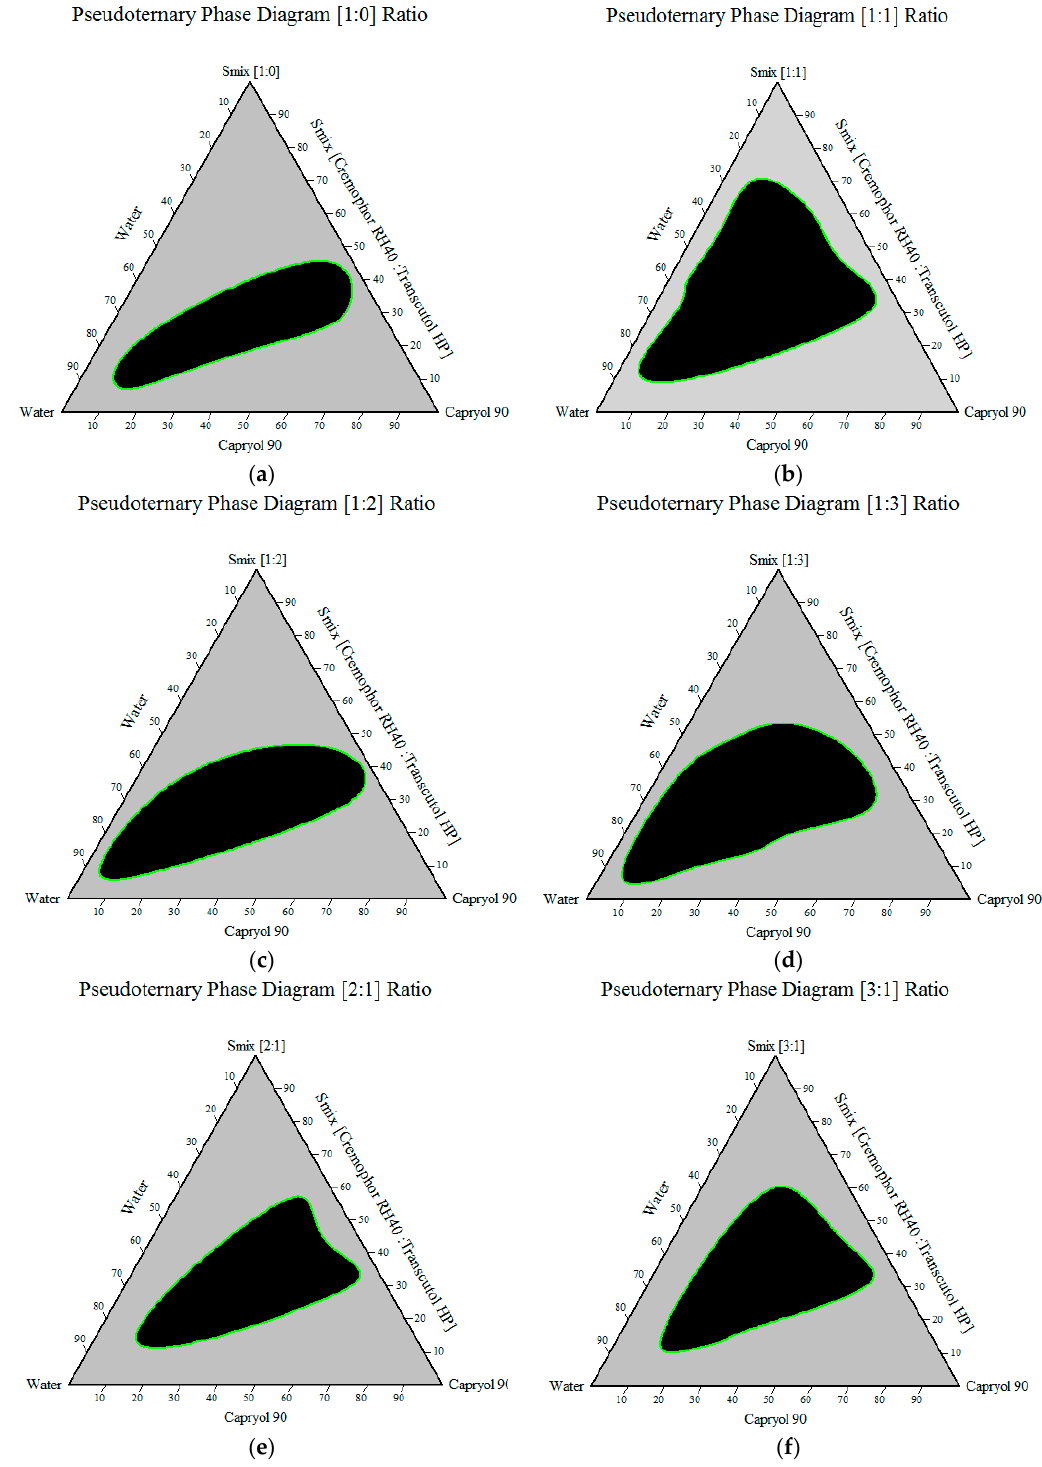
Figure 3. Pseudo-ternary phase diagram of Smix ( a ) [1:0]; ( b ) [1:1]; ( c ) [1:2]; ( d ) [1:3]; ( e ) [2:1]; ( f ) [3:1].